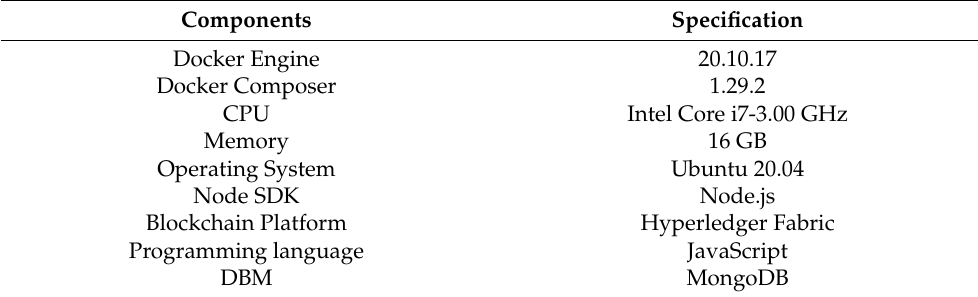
Table 3. Development environment of the proposed framework.